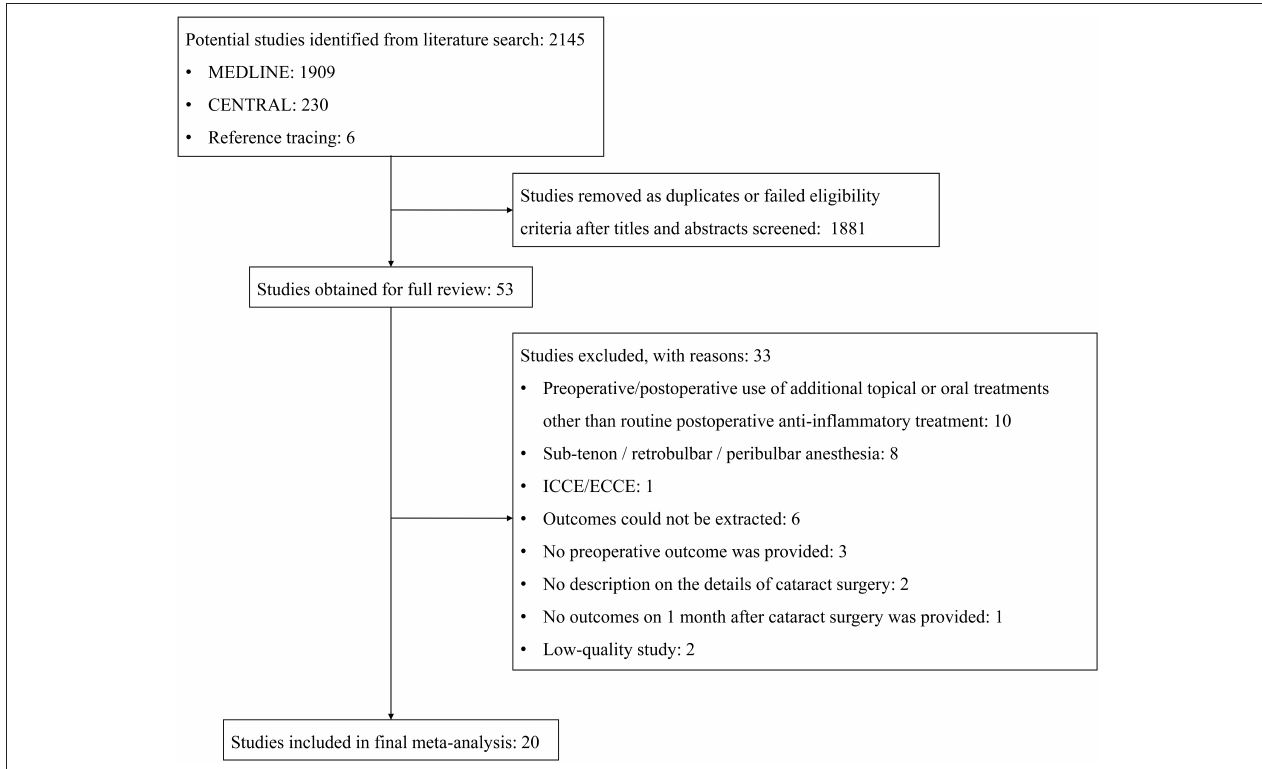
FIGURE 1 | Flow diagram of the selection process for studies included in the meta-analysis. CENTRAL, Cochrane Central Register of Controlled Trials; ICCE, intracapsular cataract extraction; ECCE, extracapsular cataract extraction.